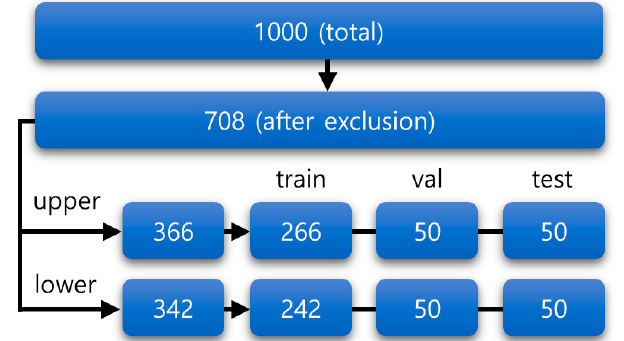
Figure 1. Overview of the datasets. After excluding the data with the exclusion criteria, remaining data were separated into train, validation, and test datasets. The train dataset was used for training the model, and the validation dataset was used for assessing the overfitting. The test dataset was used for evaluation. Each digit represents the number of periapical radiographs. The upper and lower periapical radiographs are shown separately.